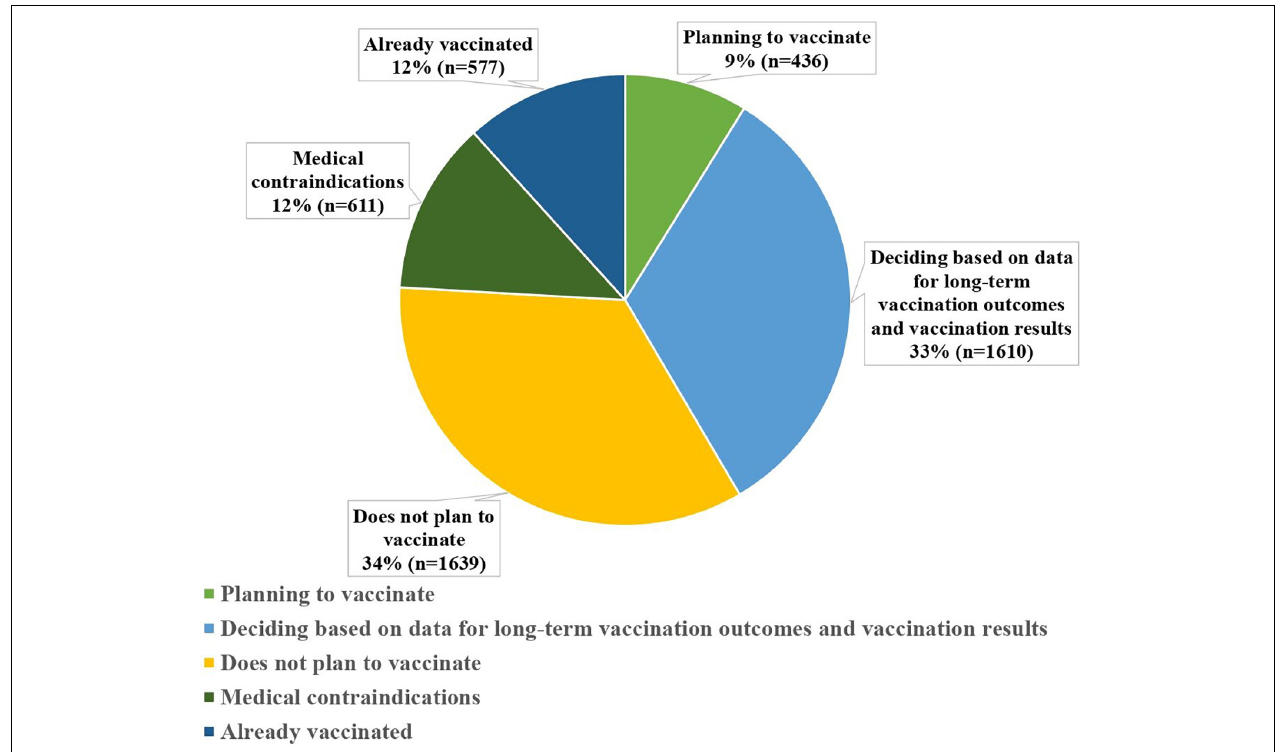
FIGURE 1 | Vaccination behavior types as presented in the study